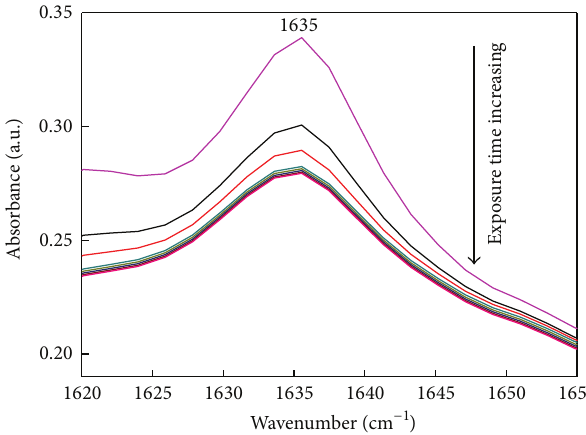
Figure 6: The absorbance variance at 1635 cm −1 of the microcap- sules under exposure.